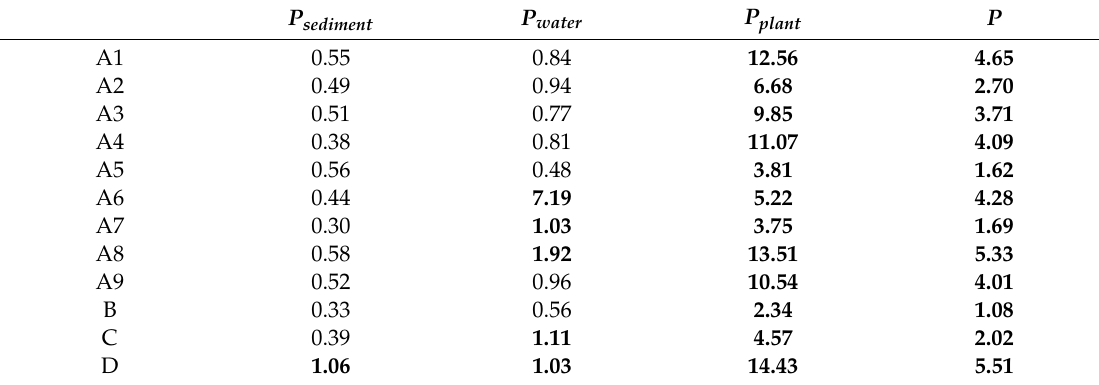
Table 1. Nemerow’s synthetic pollution index analysis results for various sampling points.